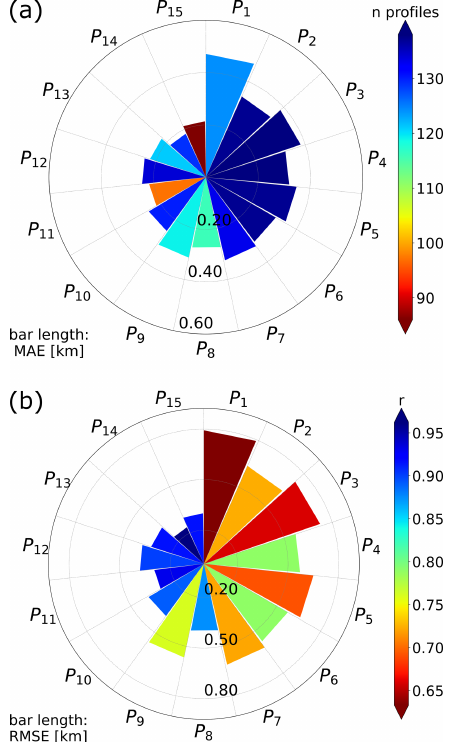
Figure 11. Errors in the ML detection for QVPs using a ± 30min window. In panel (a) , the bar length represents the MAE (in kilome- tres), and colour represents the number of QVPs with strong signa- tures detected by every polarimetric combination; in panel (b) , the bar length represents the RMSE (in kilometres) for every polari- metric combination, and colour represents the Pearson correlation